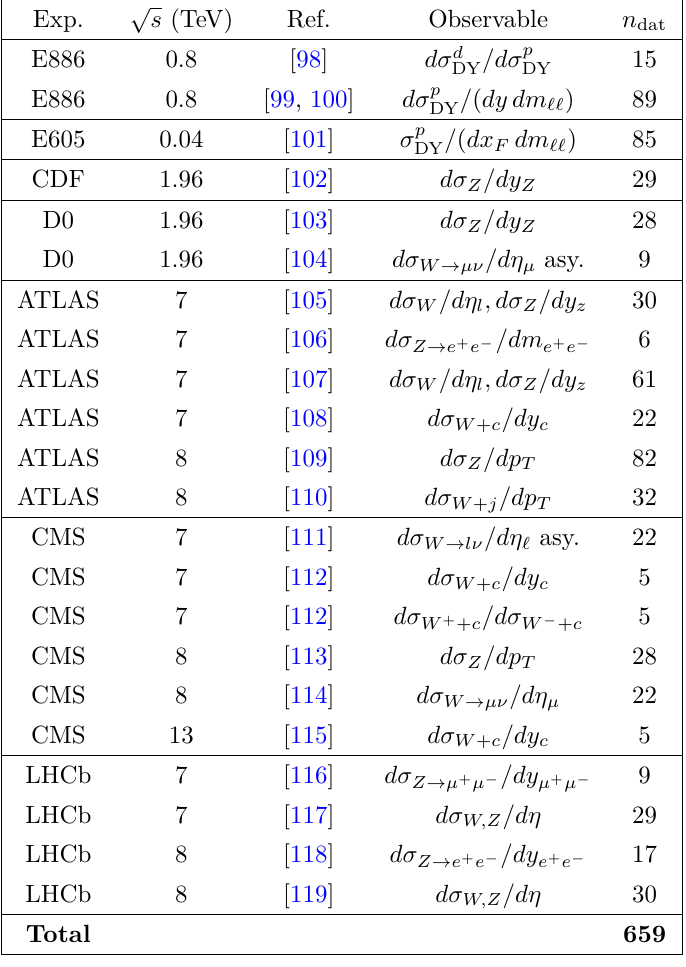
√ s , the publication reference, the physical